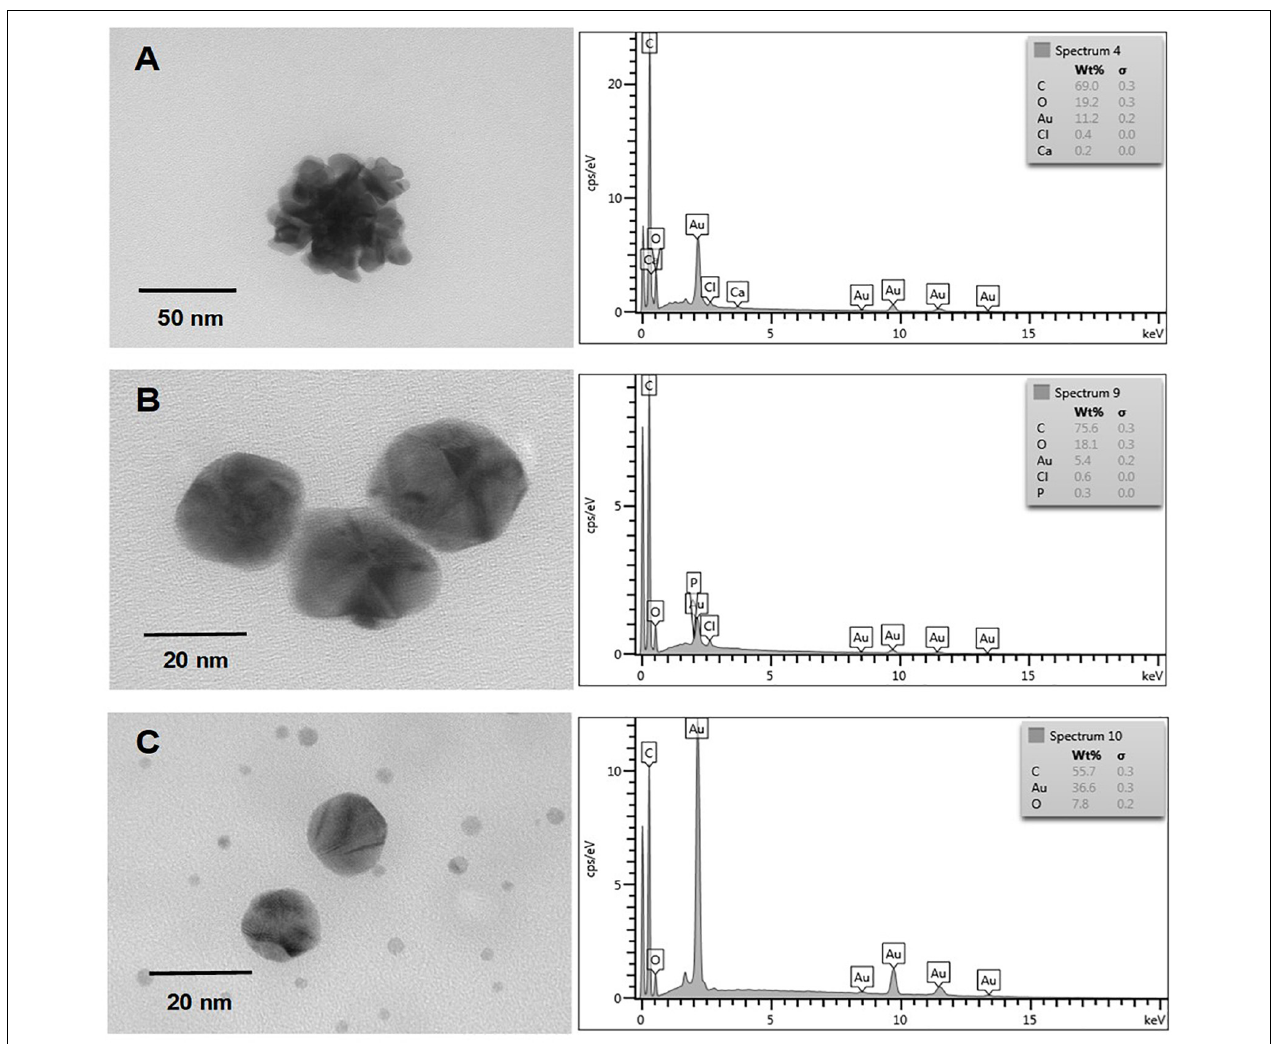
FIGURE 6 | In vitro , anaerobic synthesis of AuNS by E. cloacae MF01 crude extracts. Electron micrographs (left) and EDS analysis (right) show AuNS synthesized under the following experimental conditions: (A) NADH/pH 8.0; (B) NADH/pH 9.0; (C) NADPH/pH